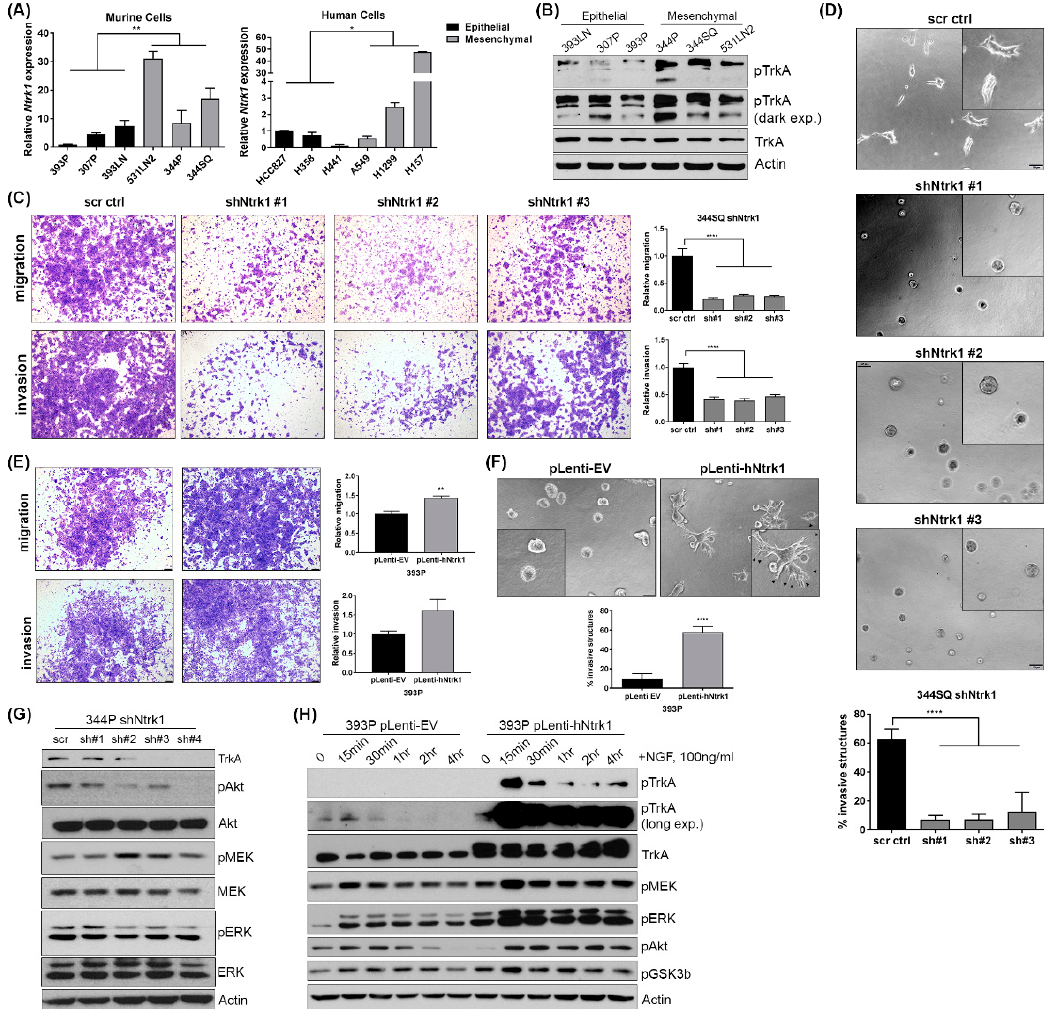
Figure 3. Ntrk1 expression correlates with cells in a mesenchymal state and regulates cell migration, invasion, and AKT and MAPK signaling pathways. ( A ) Real-time qPCR data for Ntrk1 expression in 3 epithelial and 3 mesenchymal murine KP lung cancer cell lines (left) and in 3 epithelial and 3 mesenchymal human lung cancer cell lines (right). ( B ) Western blot showing phospho-TrkA expression in murine KP lung cancer cells as a function of epithelial and mesenchymal status. Actin was used as a loading control. ( C ) Ntrk1 was stably depleted using 3 different shRNA sequences. 344SQ Ntrk1 knockdown cells were plated in triplicate in transwell chambers with Matrigel to measure invasion or without to measure migration. After 16 hours, cells that had migrated or invaded were fixed and stained with crystal violet. Representative images of a single chamber are shown. Quantifications were done using ImageJ and are graphed to the right as a fold change compared to non-targeting scrambled control cells. ( D ) 344SQ shNtrk1 cells were plated on a 50% Matrigel:50% collagen type I matrix. Images were taken after 3 days and the percentage of invasive structures was quantified and graphed below. ( E ) Human cDNA encoding for Ntrk1 was stably introduced into 393P cells. These cells were plated in migration and invasion transwell assays as described in panel C. Representative images are shown and quantifications are graphed to the right. ( F ) 393P Ntrk1 overexpressing cells were plated on a Matrigel and collagen type 1 mixed matrix as described in panel D. Invasive structures were quantified and are shown in the graph below. ( G ) Western blot analysis of 344P Ntrk1 knockdown cells to examine protein expression of TrkA to confirm knockdown and signaling pathways including AKT and MEK/ERK. Actin was used as a loading control. ( H ) 393P empty vector (EV) and Ntrk1 overexpression cells were stimulated with NGF over the course of 4 hours and protein collected for western blot analysis of phospho-TrkA, and AKT and MEK/ERK signaling